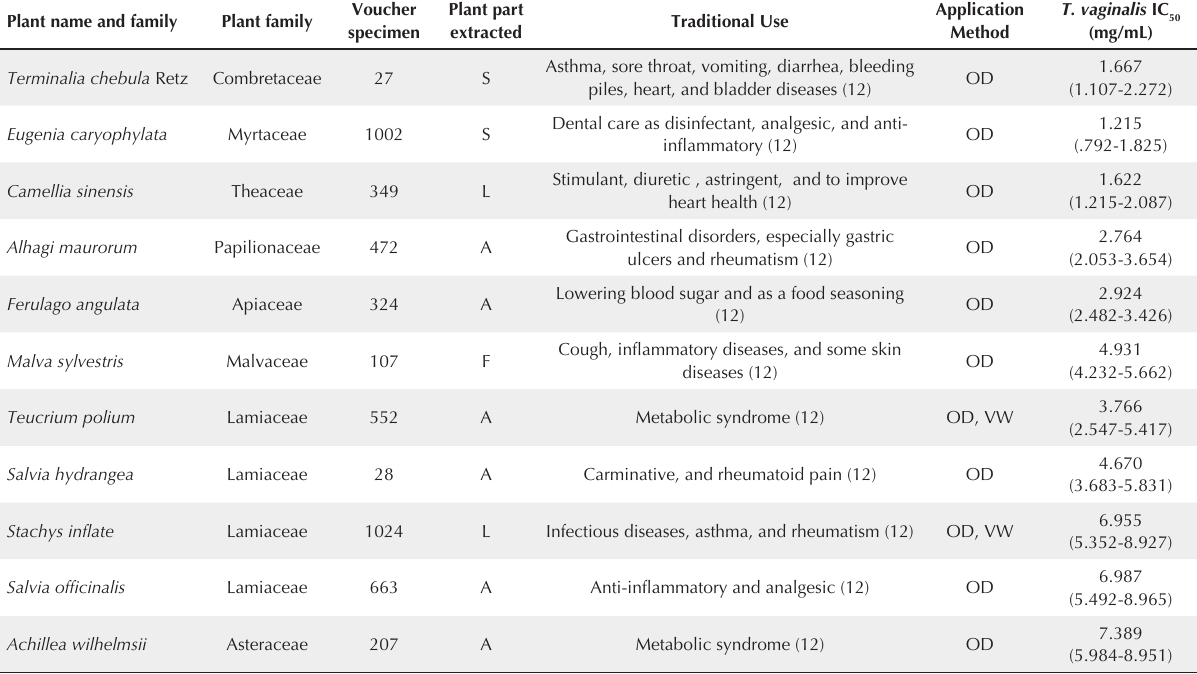
Table 1. Effect of selected plants on Trichomonas vaginalis Plant name and